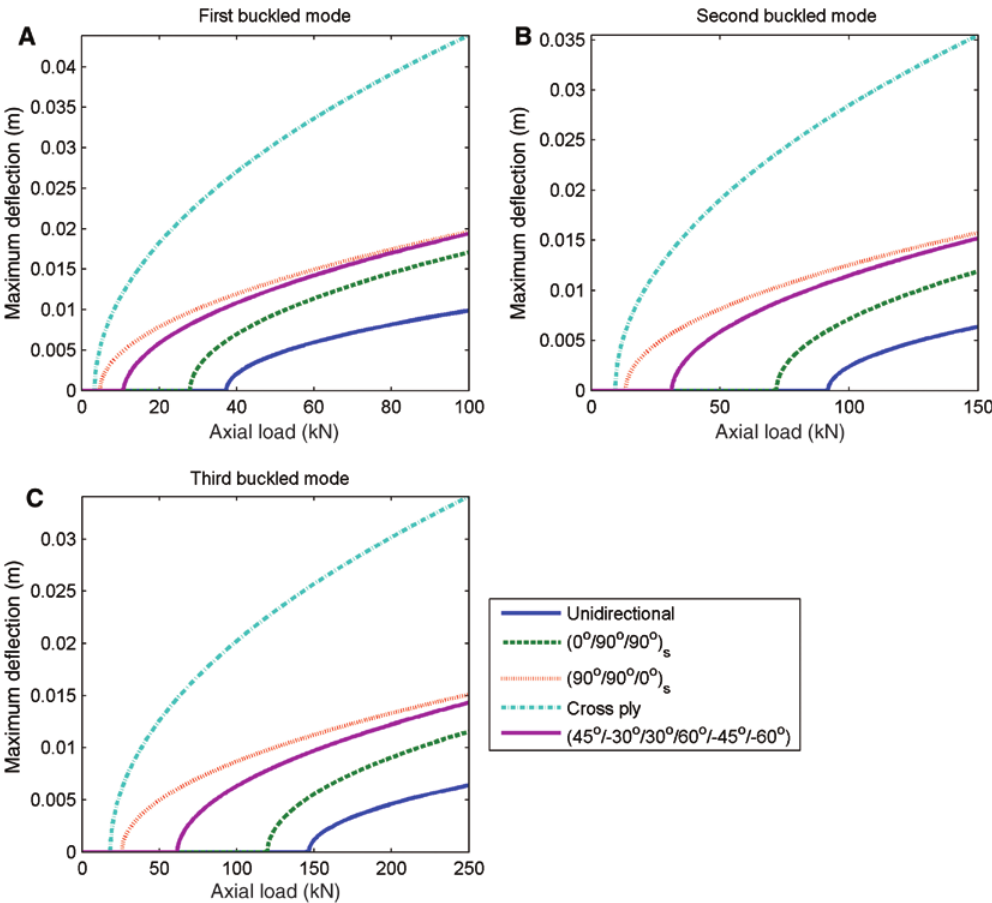
Figure 2 Static bifurcation diagrams of the first three buckled configurations for different laminates of an SC